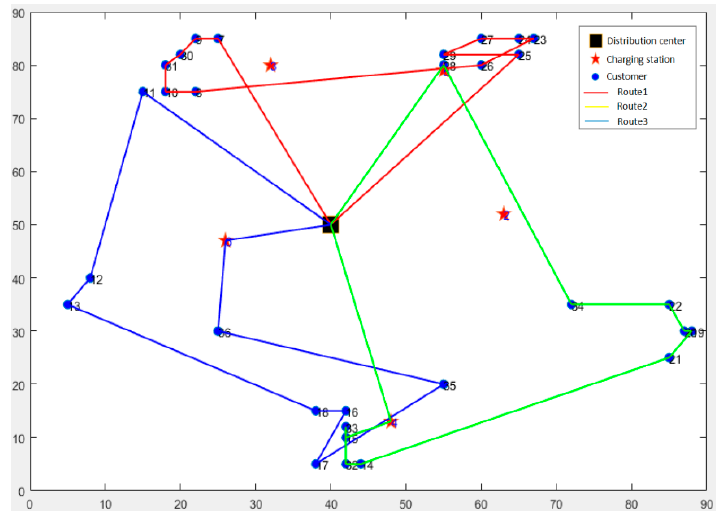
Figure 4. The optimal distribution paths of Capacitated Electric Vehicle Routing Problem with Time